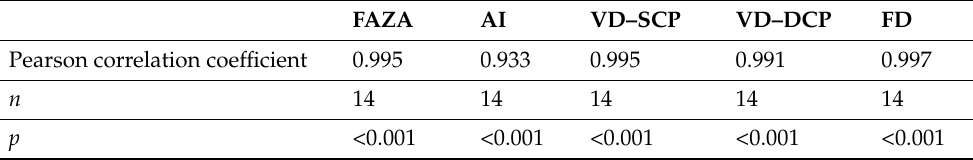
Table 2. Intraclass correlation coefficient on reproducibility of the measurements using Pearson’s correlation coefficient.